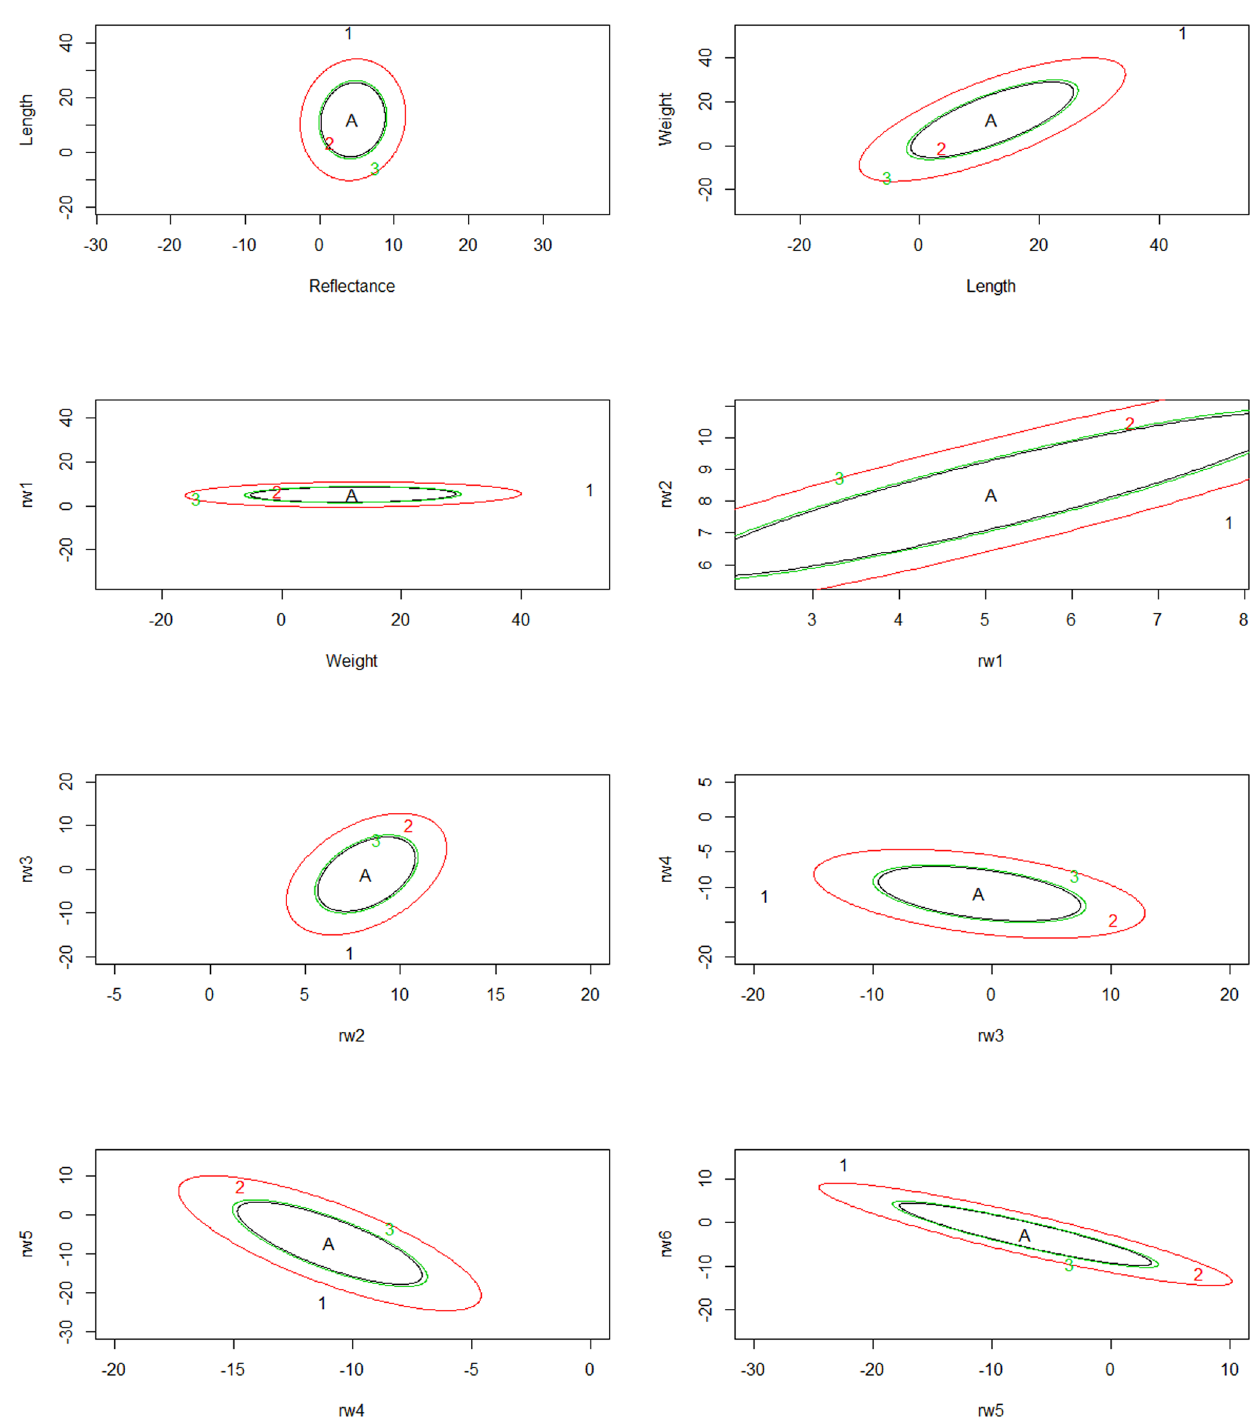
Figure 5. Phenotypic trait distributions for the mean ancestral (A) genotype for trait pairs under neutral expectations at sampling period 3, together with observed population trait values in Assinica (1), Iron River (2), and Siskiwit (3).